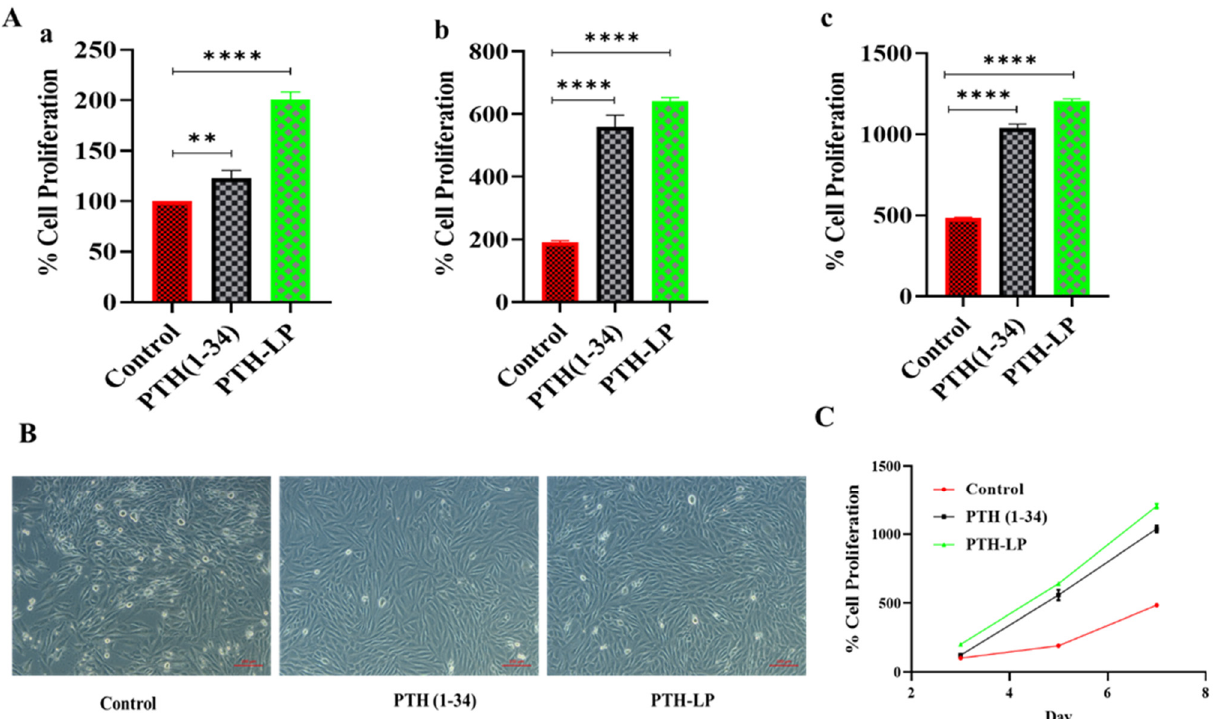
Figure 7. Cell proliferation assay of PTH-LPs. ( A ) % cell proliferation of PTH-LPs on MG-63 cells at 3 ( Aa ), 5 ( Ab ), and 7 ( Ac ) days. ( B ) Microscopic images of MG-63 cell after 3 days of incubation. ( C ) Line graph for % cell proliferation of MG-63 cells after 3, 5, and 7 days of incubation. Scale bar: 100 µm. ** p < 0.01, **** p < 0.0001.